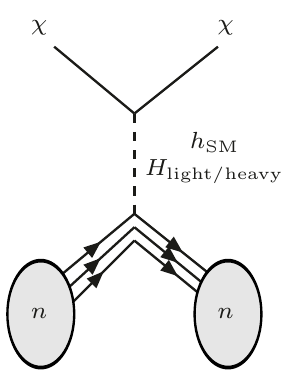
Figure 6 . Feynman diagrams for DM to interact with